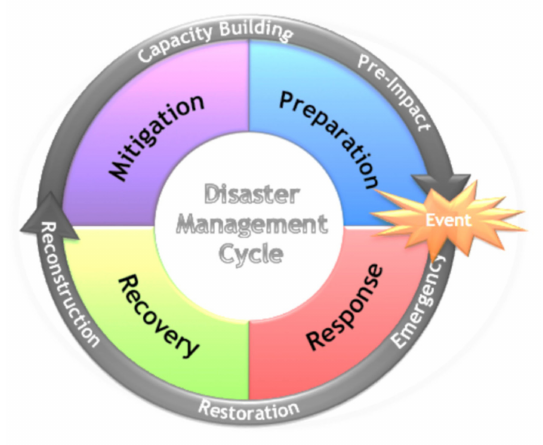
Figure 14. The Disaster Risk Management